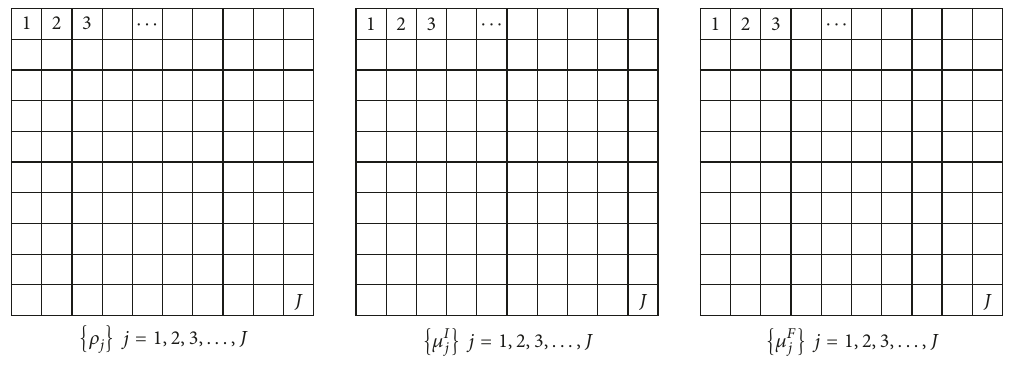
Figure 5: The matrices defined for